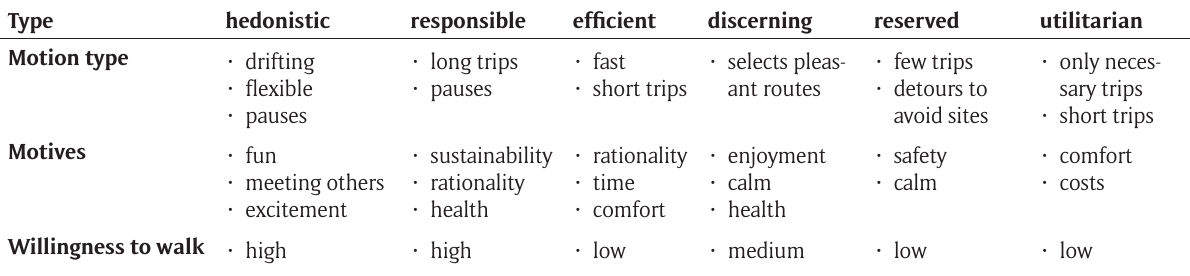
Table 2: Key characteristics and motives of pedestrians (based on Millonig, 2014; Markvica et al., 2020).